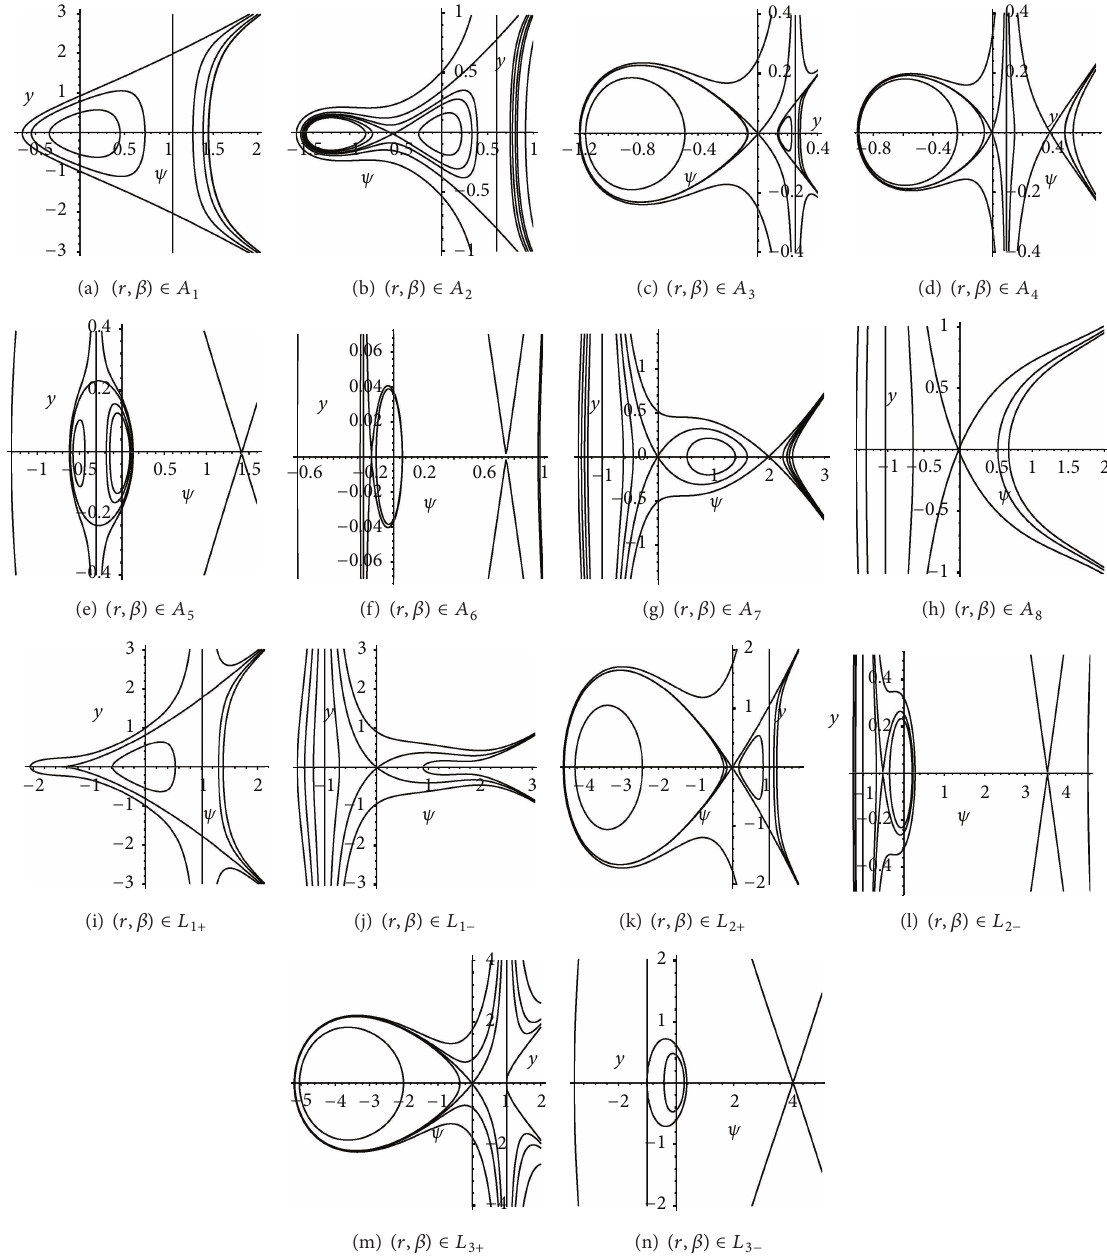
Figure 2: The phase portraits of (8) for 𝛼 < 0